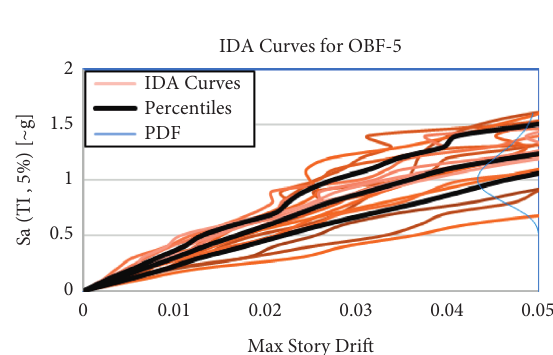
Figure 20: IDA curves obtained for OBF-5.